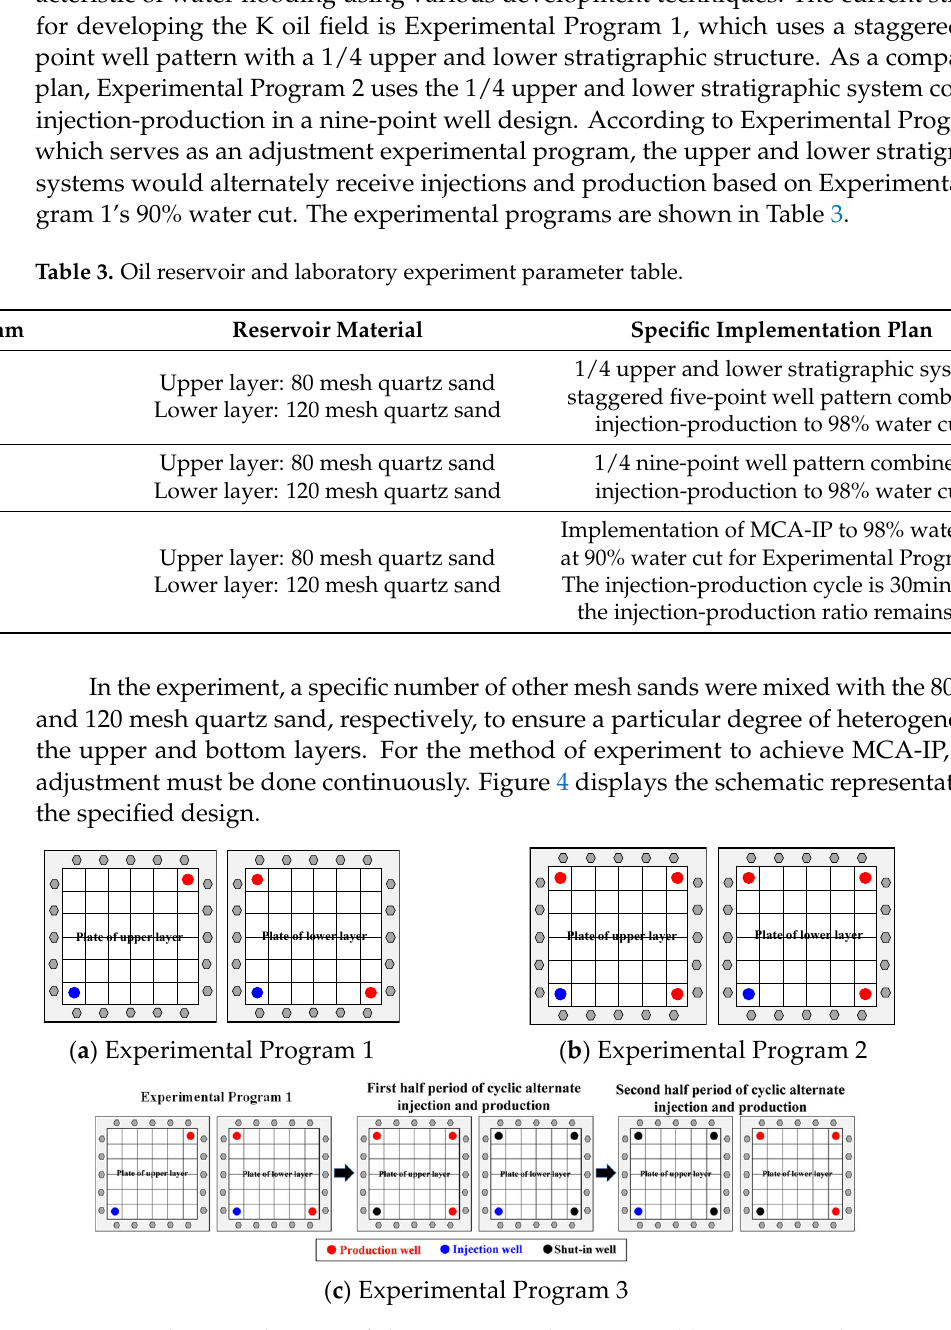
Figure 4. Schematic diagram of the experimental program. ( a ) Experimental Program 1: one production well and one injection well in the upper layer, two production wells and one injection well in the lower layer; ( b ) Experimental Program 2: three production wells and one injection well in the upper layer, three production wells and one injection well in the lower layer; ( c ) Experimental Program 3: first half period of cyclic alternate injection and production: three production wells and one shut-in well in the upper layer, three shut-in wells and one injection well in the lower layer; second half period of cyclic alternate injection and production: three shut-in wells and one injection well in the upper layer, one shut-in well and three production wells in the lower